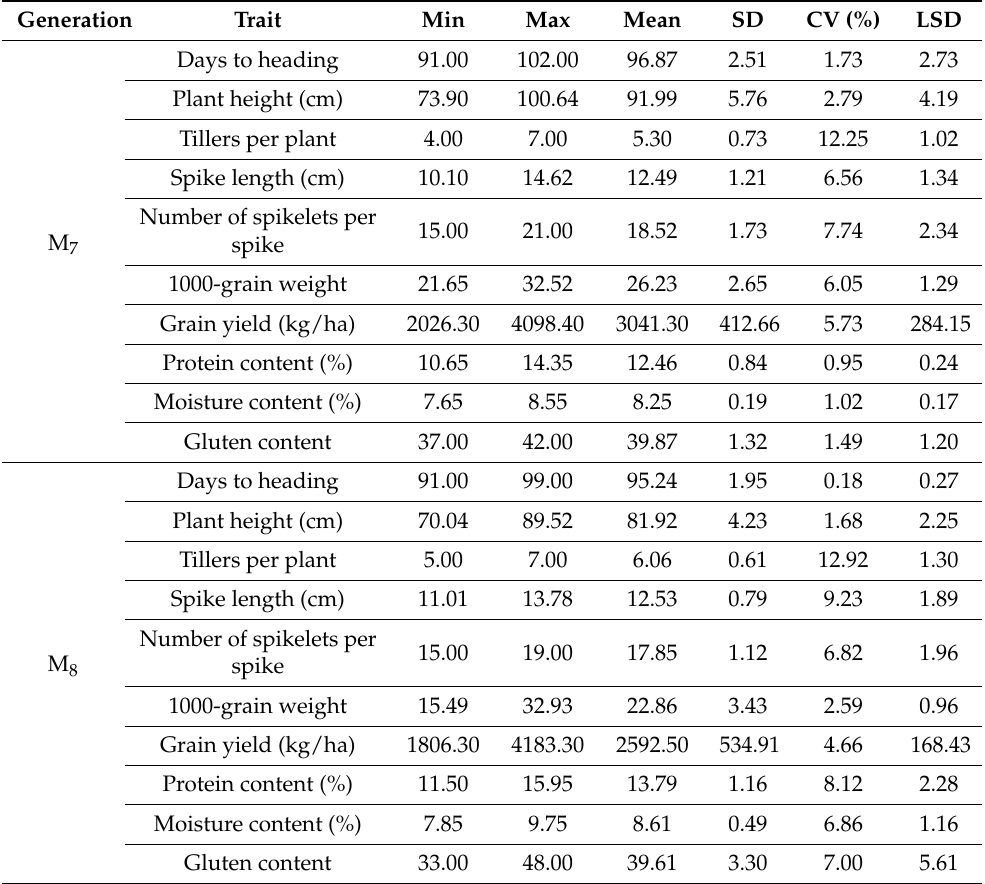
Table 3. Descriptive statistics of all traits calculated for 32 mutant lines and the wild type in M 7 and M 8 generations at the NIBGE